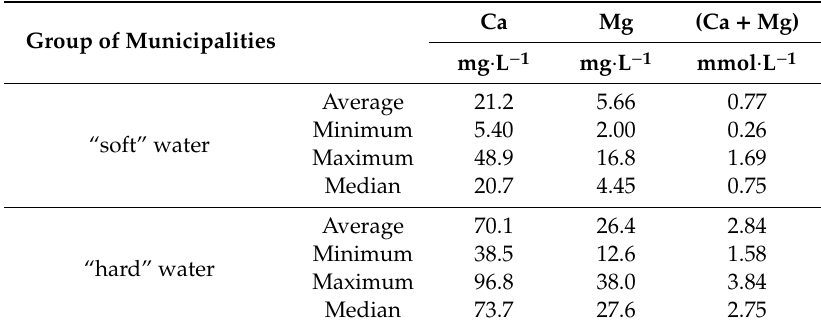
Table 1. Statistical summary of Ca and Mg contents and water hardness in “soft” and “hard” water groups.